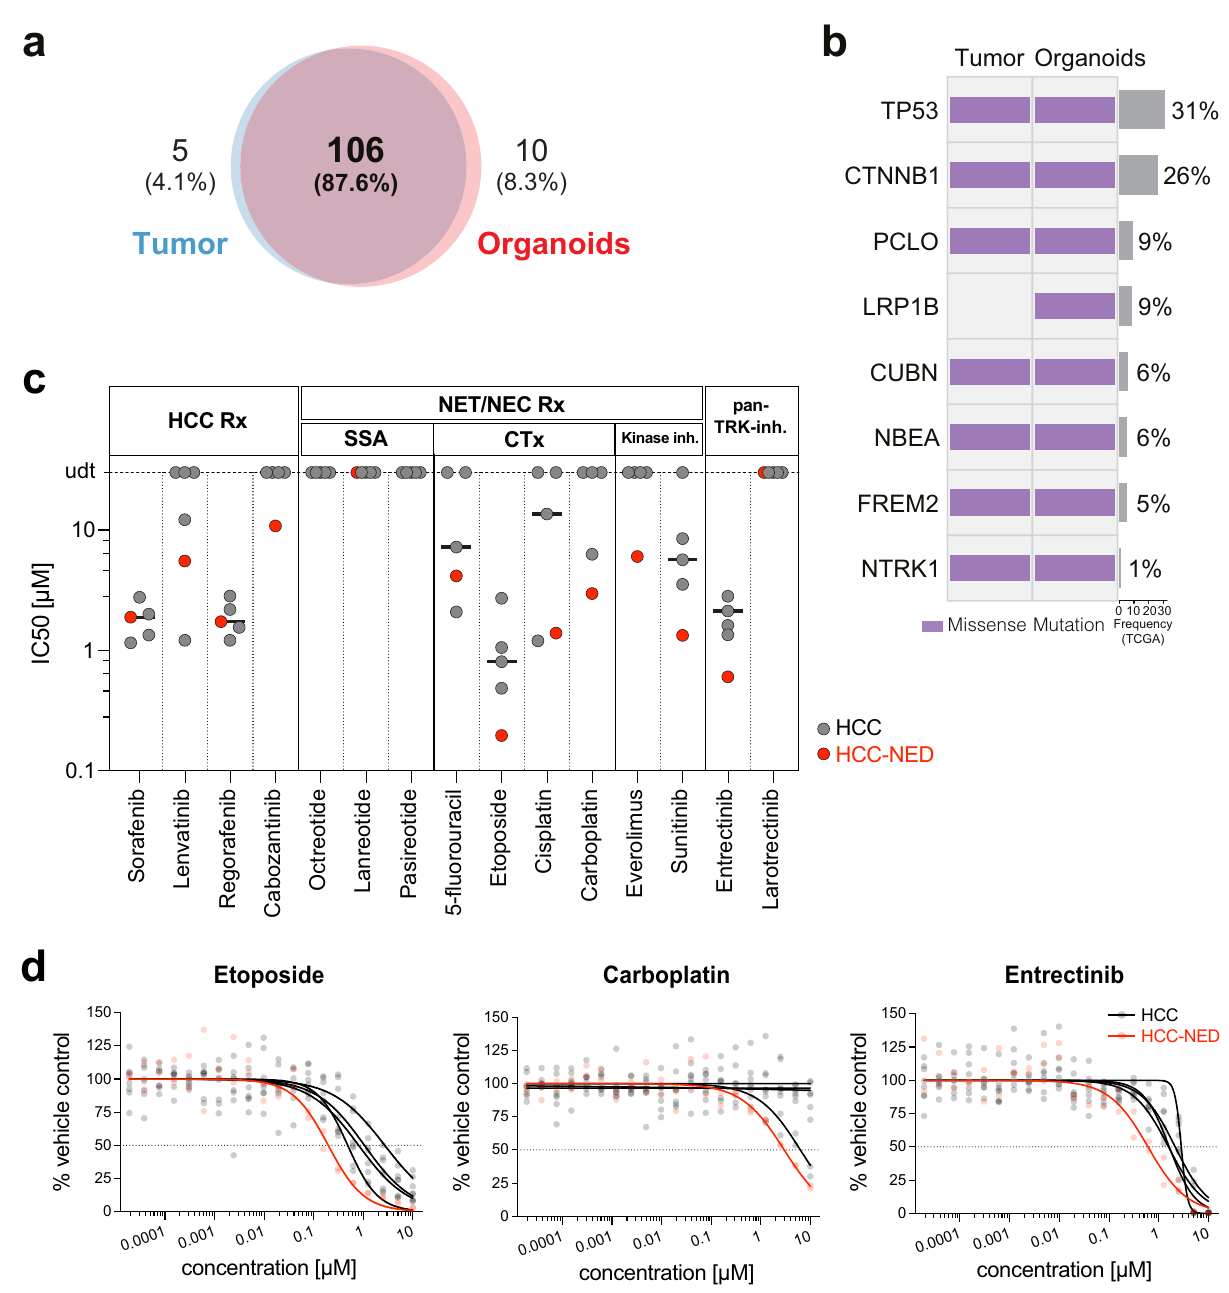
Fig. 2 Genetic characterization of HCC-NED and drug screening using patient-derived organoids. a Venn diagram representing the number of somatic mutations detected in each sample using whole-exome sequencing (WES). b Oncoprint of genetic alterations detected in the HCC-NED tumor and its matched organoids by WES. Alterations are colored according to the legend. Alterations shown are those included in the cancer gene list (Supplementary Data 1). c Half maximal inhibitory concentration (IC50) as determined in the HCC-NED (colored in red) and four different HCC organoid lines (colored in black). Horizontal lines indicate the median IC50. CTx chemotherapy, HCC hepatocellular carcinoma, HCC-NED hepatocellular carcinoma with neuroendocrine differentiation, inh. inhibitors, NEC neuroendocrine carcinoma, NET neuroendocrine tumor, Rx therapy, SSA somatostatin analogs. d Dose- response curves for the chemotherapeutics etoposide and carboplatin as well as the pan-TRK inhibitor entrectinib with concentrations ranging from 0.02 nM to 10 µ M. The HCC-NED organoid line is colored in red, the four HCC organoid lines included as reference in black. After 6 days of treatment, an ATP-based readout was used as a surrogate for cell number. All values were normalized to vehicle control (DMSO or water) and are displayed as the mean of n = 2 biologically independent experiments. DMSO dimethyl